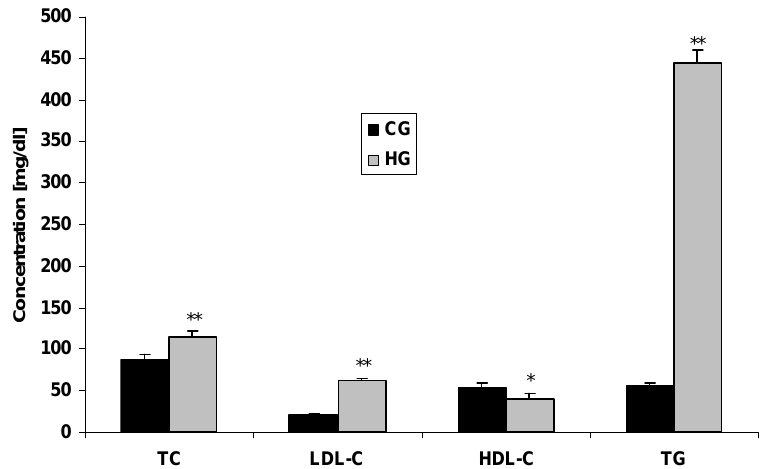
Figure 1. Effect of Triton-WR1339 on lipid profile after 12 h.